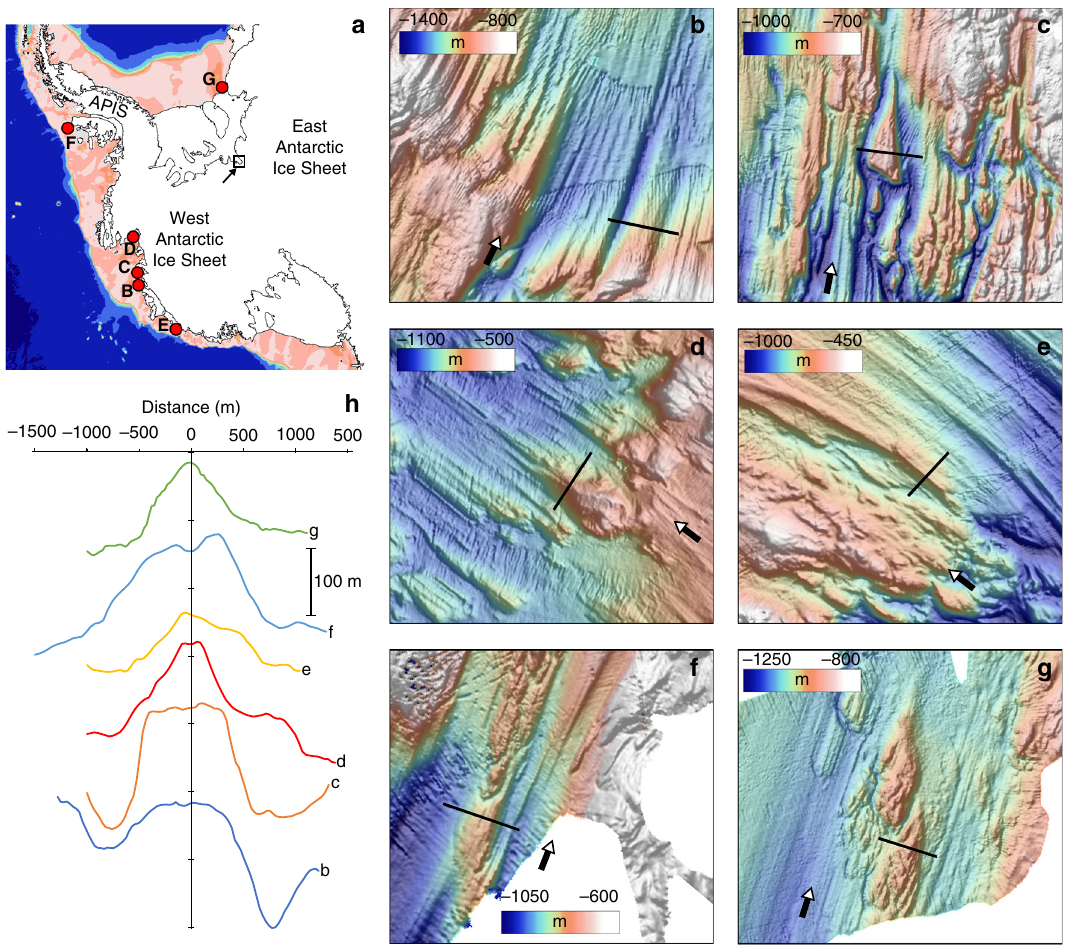
Fig. 3 High-resolution multibeam echo-sounder swath bathymetry datasets for the Antarctic shelf, showing examples of relict hard-bedded landforms with dimensions directly comparable to those imaged with radar beneath the trunk of Foundation ice stream. a Location map of six individual sites spanning the East Antarctic, West Antarctic, and Antarctic Peninsula coastlines; letters refer to the data shown in the subsequent panels, b – g . b , c Subglacial bedforms carved into crystalline basement in front of the Getz B ice shelf, and Dotson Ice Shelf, respectively 41,51 . Grid cell size 30 m. d Crag-and-tail like bedforms in a crystalline substrate seaward of Pine Island Glacier 33 . Grid cell size 35 m. e Inner shelf bathymetry from the Hobbs Coast region of the westernmost Amundsen Sea/eastern Ross Sea 52 . Grid cell size 30 m. f Hard-bedded landforms on the middle continental shelf north of the Wilkins Ice Shelf. Data collected on cruise JR179 51 . Grid cell size 30 m. g Sea- fl oor landforms in bedrock in the southeastern Filchner Trough. Data collected on cruise JR244 53 . Grid cell size 25 m. h Cross-pro fi les of landforms as shown in panels b – g (thin black lines). Together panels b – h demonstrate that mega-scale hard-bedded landforms are common around the Antarctic coastline. In all cases, the larger bedforms are overprinted or found adjacent to smaller-scale landforms with reduced amplitudes and wavelengths that are more typical of sedimentary and bedrock-moulded sub-ice stream landscapes. We presume that these subglacial bedforms also have an effect in corrugating the ice shelf base but to a much lesser extent than the rarer and more prominent hard-bedded glacial landforms. Thick black scale bar is 5 km. Filled arrows show former ice fl ow direction. APIS: Antarctic Peninsula Ice